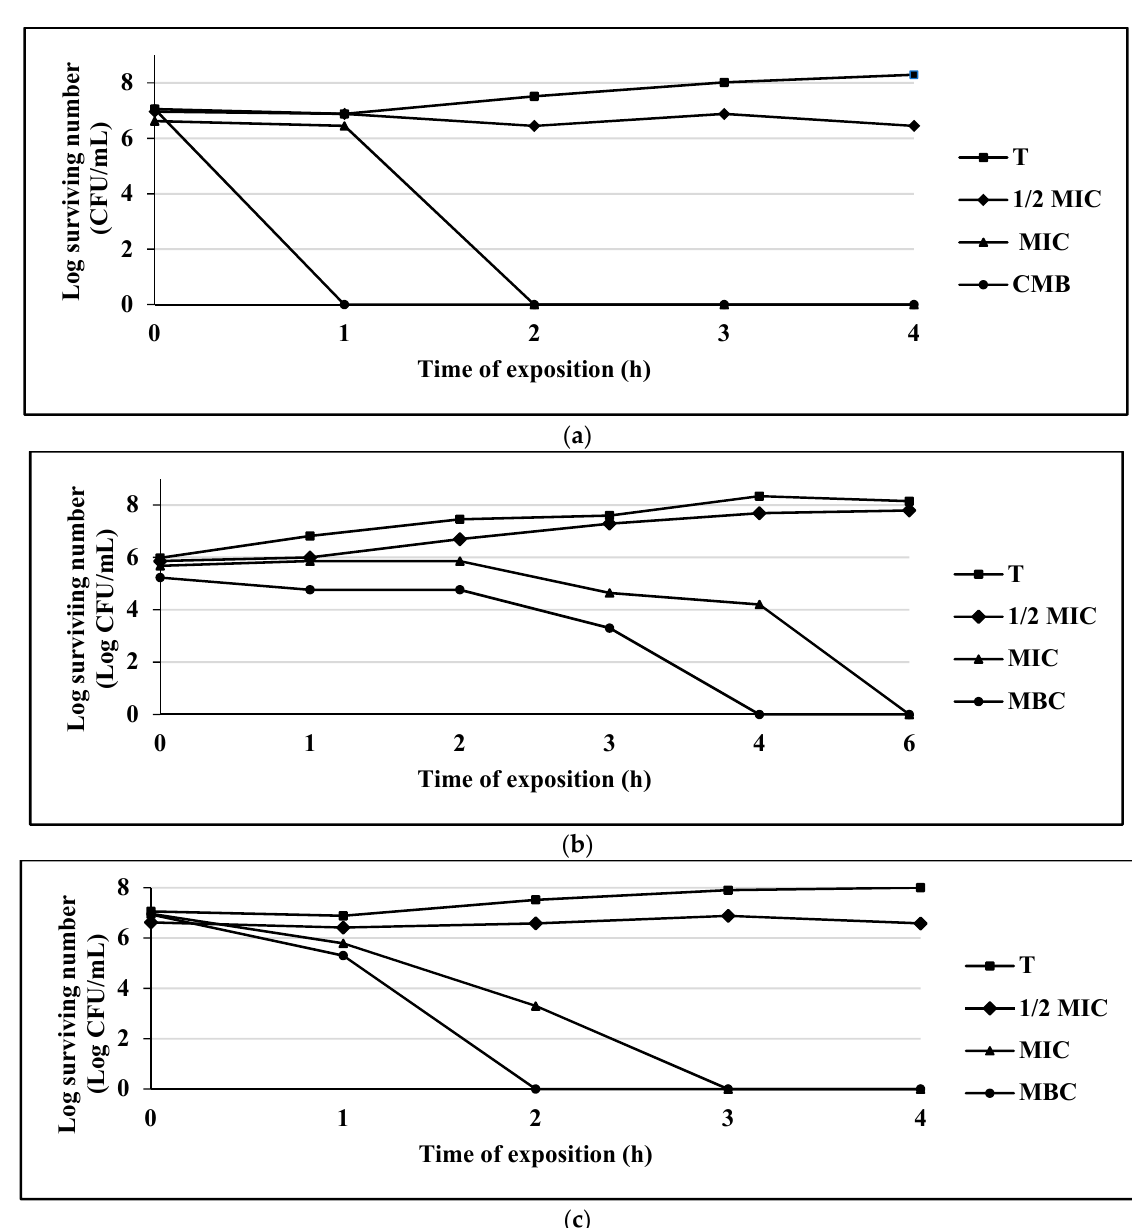
Figure 3. ( a ) Survival curve of E. coli exposed to thymol . Data are represented as the mean ± S.E. ( n = 3). The concentrations used were: 0.125 mg/mL (½ MIC), 0.25 mg/mL (MIC), and 0.50 mg/mL (MBC); the control group (T) only contains the bacterial culture. ( b ) Survival curve of S. aureus 75MR exposed to thymol . Data are represented as the mean ± S.E. ( n = 3). The concentrations used were: 0.25 mg/mL (½ MIC), 0.50 mg/mL (MIC), and 1.0 mg/mL (MBC); the control group (T) only contains the bacterial culture. ( c ) Survival curve of C. albicans CUSI exposed to thymol . Data are represented as the mean ± S.E. ( n = 3). The concentrations used were: 0.01 mg/mL (½ MIC), 0.03 mg/mL (MIC), and 0.062 mg/mL (MBC); the control group (T) only contains the bacterial culture.